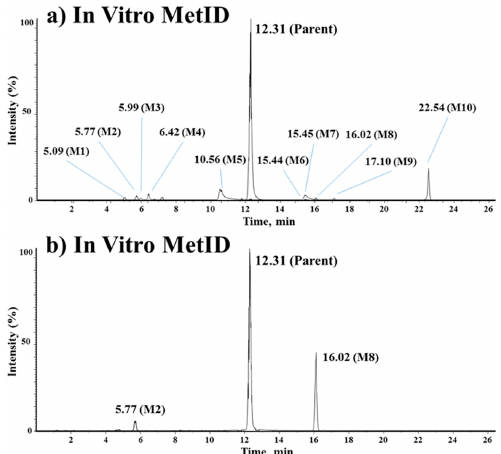
Figure 4. Extracted ion chromatogram of representative MetID samples. ( a ) in vitro (rat liver microsome) and ( b ) in vivo MetID (rat pharmacokinetic study) of vipadenant.